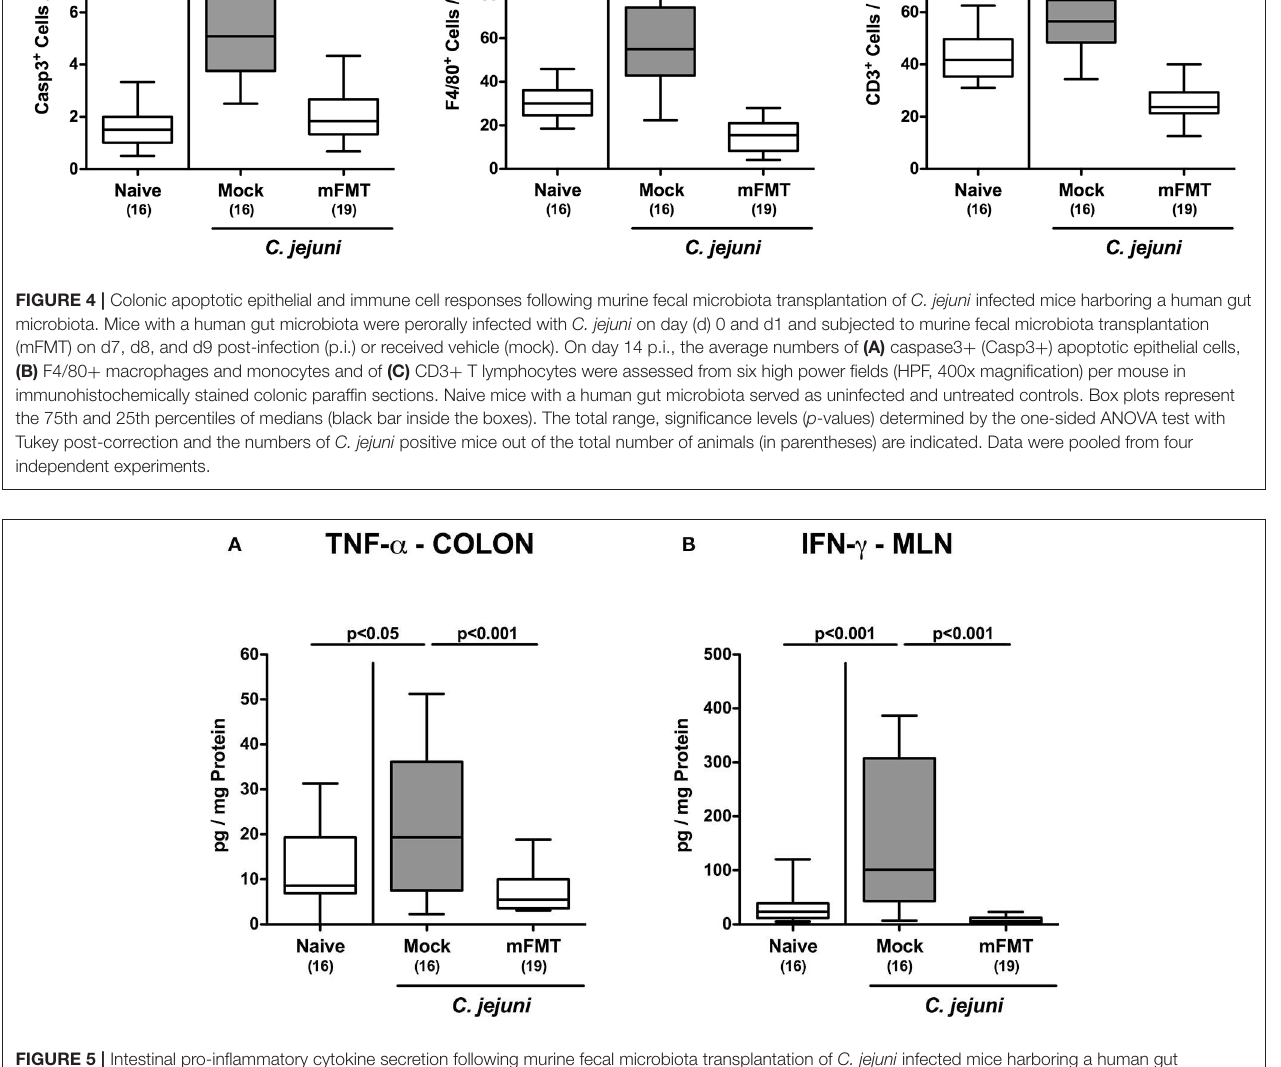
FIGURE 5 | Intestinal pro-inflammatory cytokine secretion following murine fecal microbiota transplantation of C. jejuni infected mice harboring a human gut microbiota. Mice with a human gut microbiota were perorally infected with C. jejuni on day (d) 0 and d1 and subjected to murine fecal microbiota transplantation (mFMT) on d7, d8, and d9 post-infection (p.i.) or received vehicle (mock). On day 14 p.i., (A) TNF- α and (B) IFN- γ concentrations were measured in ex vivo biopsies derived from the colon and mesenteric lymph nodes (MLN), respectively. Naive mice with a human gut microbiota served as uninfected and untreated controls. Box plots represent the 75th and 25th percentiles of medians (black bar inside the boxes). The total range, significance levels ( p -values) determined by the one-sided ANOVA test with Tukey post-correction and the numbers of C. jejuni positive mice out of the total number of animals (in parentheses) are indicated. Data were pooled from four independent